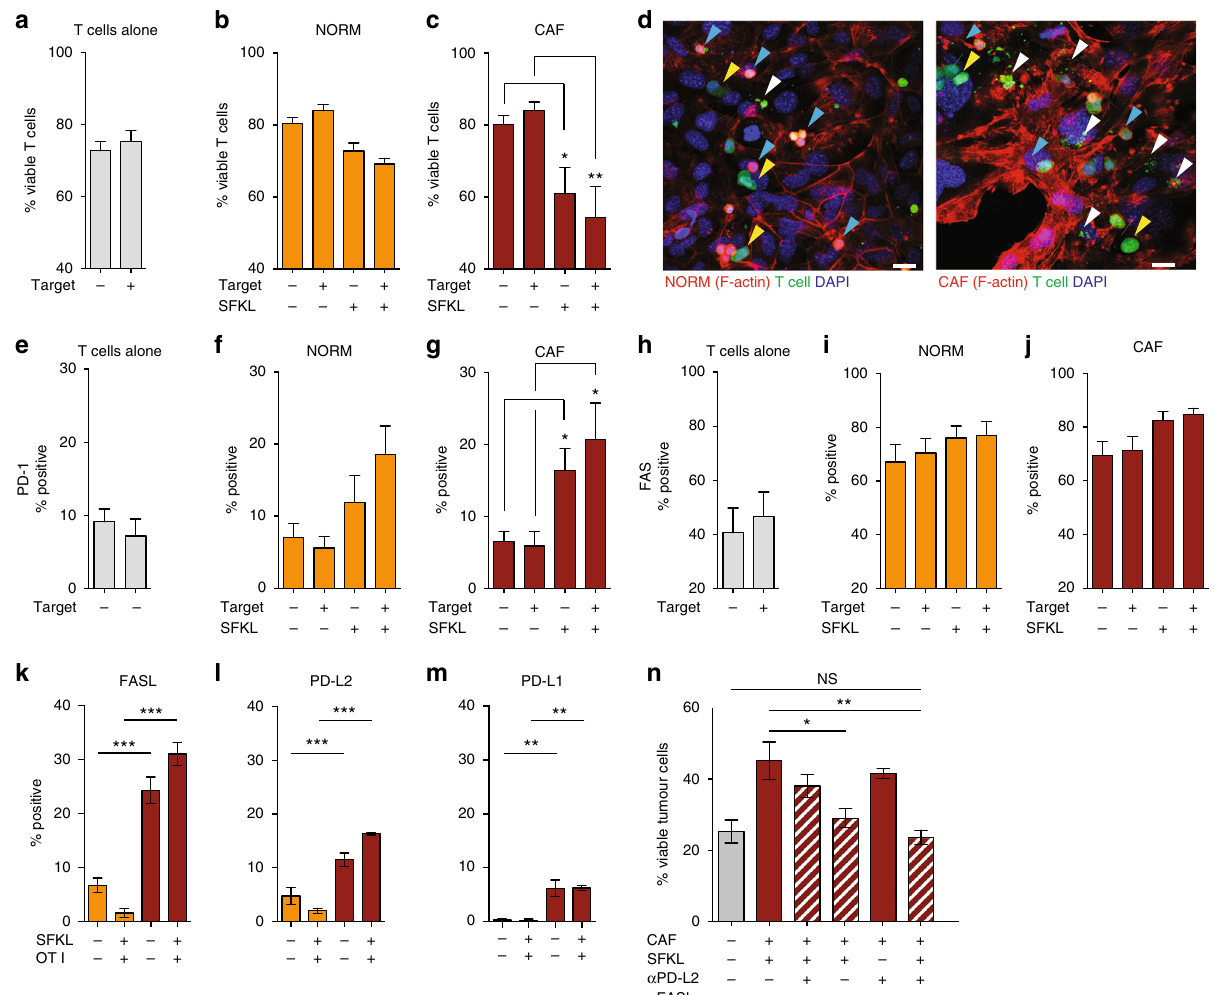
Fig. 3 CAFs reduce CD8 + T cell viability in an antigen-speci fi c death ligand dependent manner. a-c Quanti fi cation of T cell viability after conditioning in culture ( a ) or in the presence of normal fi broblasts ( b ), CAFs ( c ) and presence/absence of antigen and target tumour cells as indicated on graphs. d Representative micrographs of T cells (green) co-cultured with normal fi broblasts (red, f-actin) and CAF (red, f-actin) showing intact T cells (yellow arrows), T cells surrounded by actin bundles (blue arrows), and fragmented T cells (white arrows). Nuclei stained with DAPI (blue). Quanti fi cation of PD-1 expression ( e - g ) and FAS expression ( h - j ) on T cells following culture with normal fi broblasts ( f , i ), CAFs ( g , j ). k - m Quanti fi cation of cognate ligand expression by co-cultured fi broblasts by fl ow cytometry; FASL ( k ), PD-L2 ( l ) and PD-L1 ( m ) expression by NORM (yellow bars) and CAFs (red bars) with and without antigen and antigen-speci fi c OT-I T cells as indicated. n B16.OVA tumour cell viability following culture with CAFs, antigen and OT-1 T cells following CAF-speci fi c neutralisation of PD-L2 and/or FASL. Data shown as mean ± SEM. * p < 0.05, ** p < 0.01, *** p < 0.001, one-way ANOVA with Tukey ’ s or Dunnett ’ s post hoc analysis. NS, not signi fi cant. Comparisons indicated by horizontal lines. Scale bar 40 μ m. Assays performed in or quadruplet from two experiments ( a - c ) or duplicate from three ( e - m ) or two (n) independent